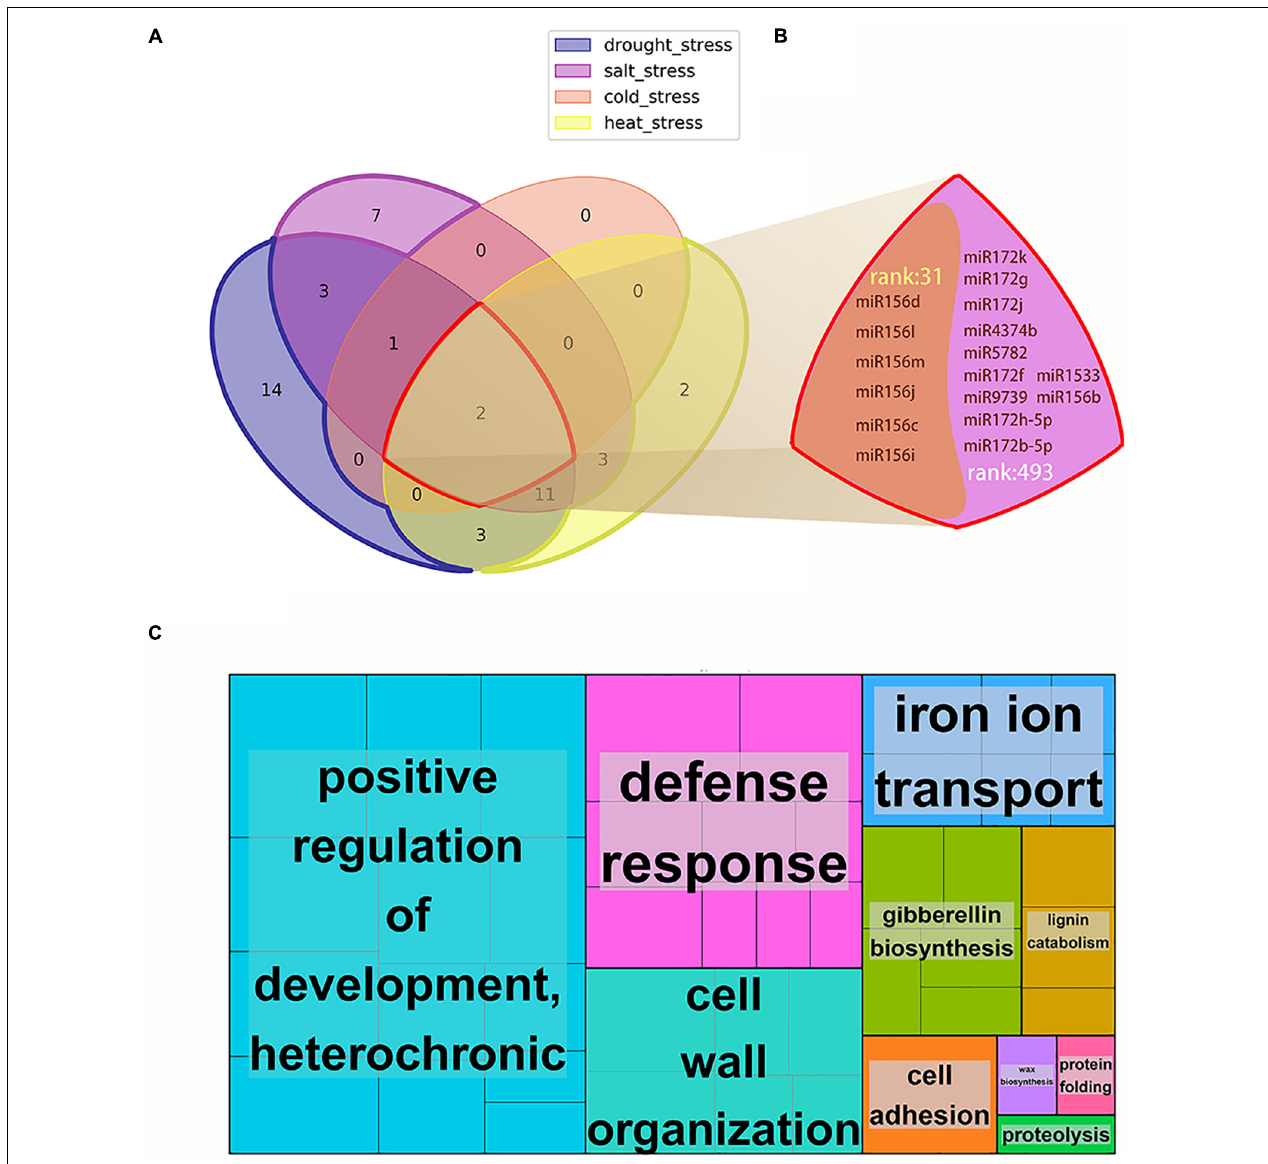
FIGURE 7 | Soybean MTRMs under various abiotic stresses. (A) Venn diagram of 37 kinds of soybean MTRMs under various abiotic stresses, including 14 drought-specific MTRMs, seven salt-specific MTRMs, two heat-specific MTRMs, and two shared MTRMs, (B) the miRNAs in the two shared MTRMs 31 and 493, and (C) a GO Treemap of 37 MTRMs under abiotic